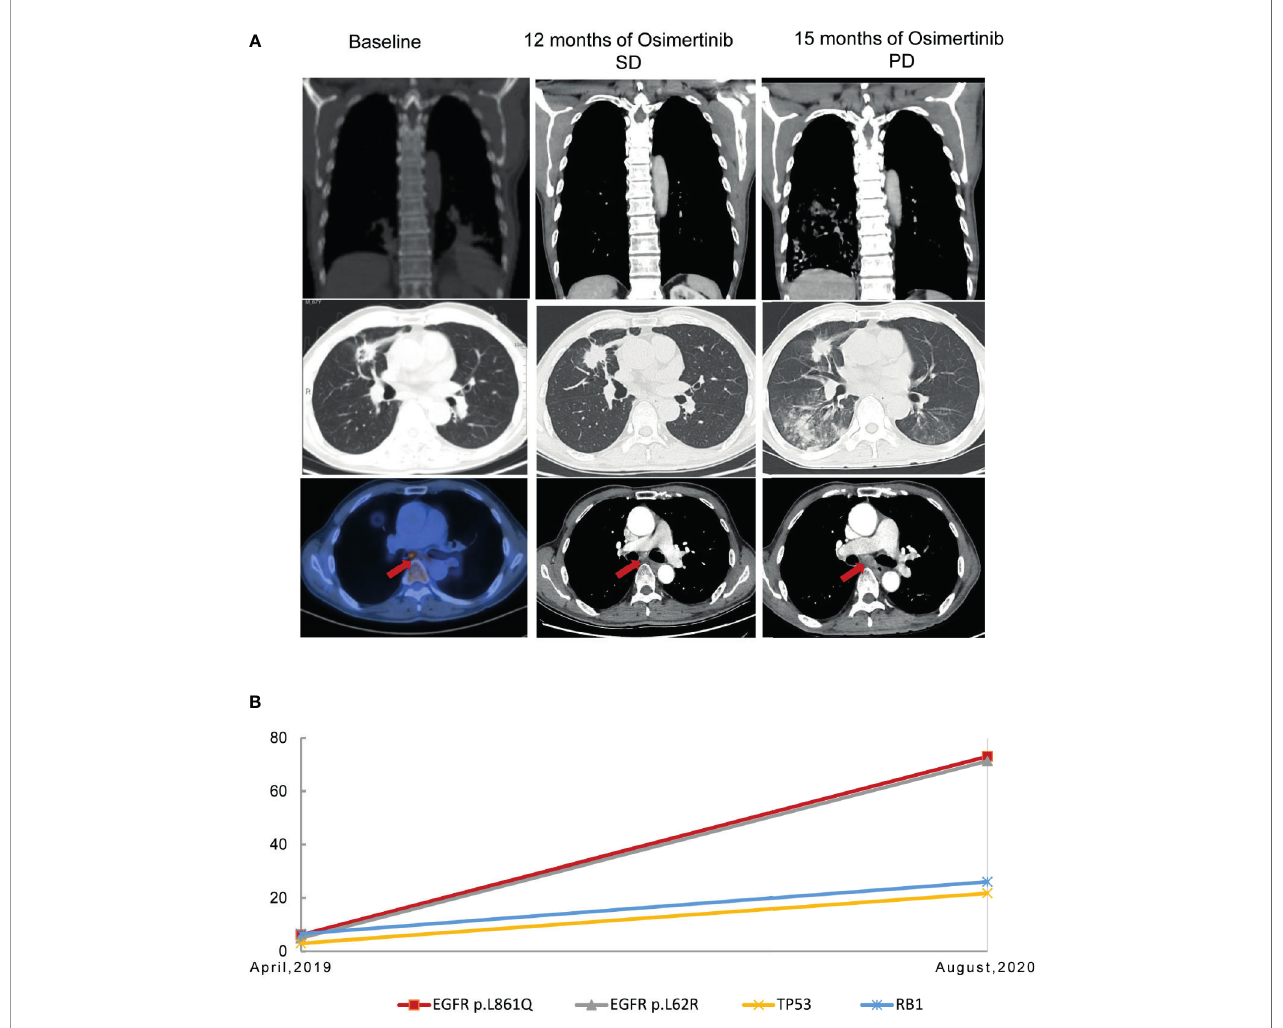
FIGURE 2 | Representative computed tomography images at various points (A) and mutation analysis of the patient ’ s plasma (B) before and after osimertinib